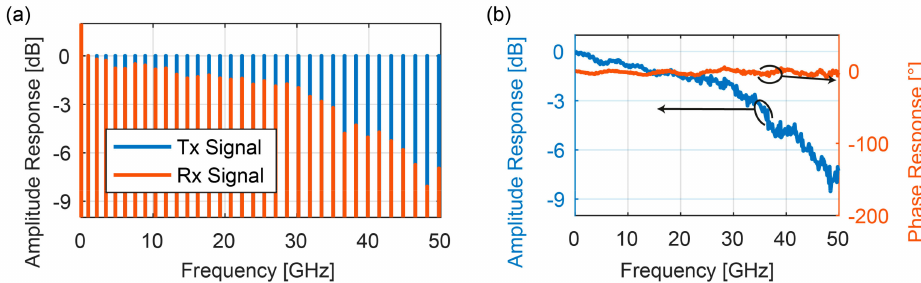
Figure 3. Characterization of frequency and phase response. ( a ) Amplitude spectrum of transmitted and received coarse non-integer spaced comb with a reduced set of 34 spectral lines. ( b ) Frequency and phase response measured with a comb of 331 spectral lines.